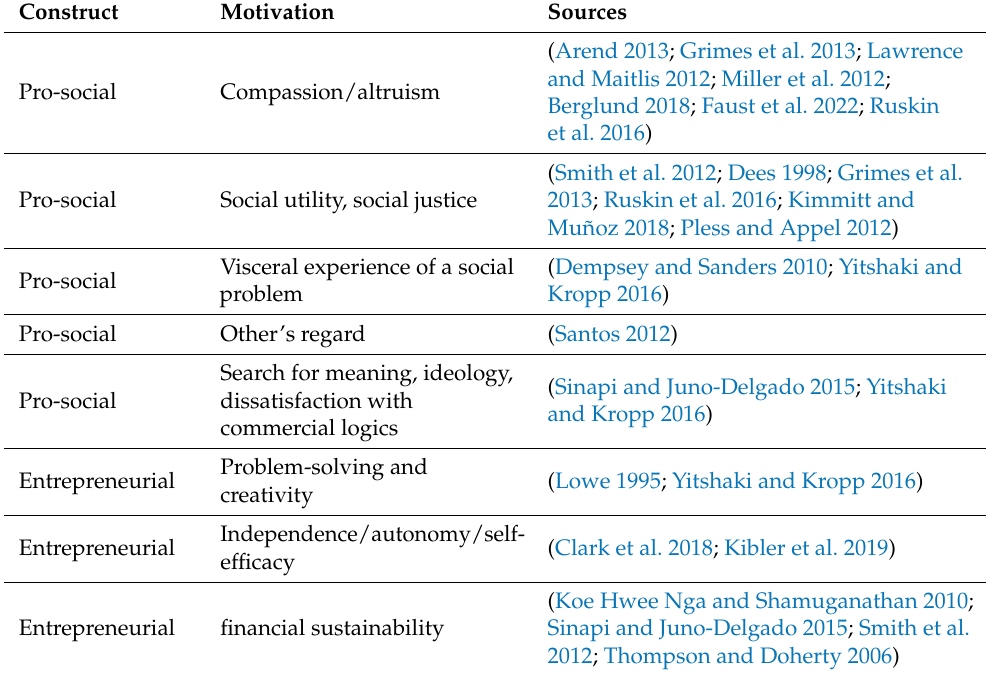
Table 1. Motivations of social